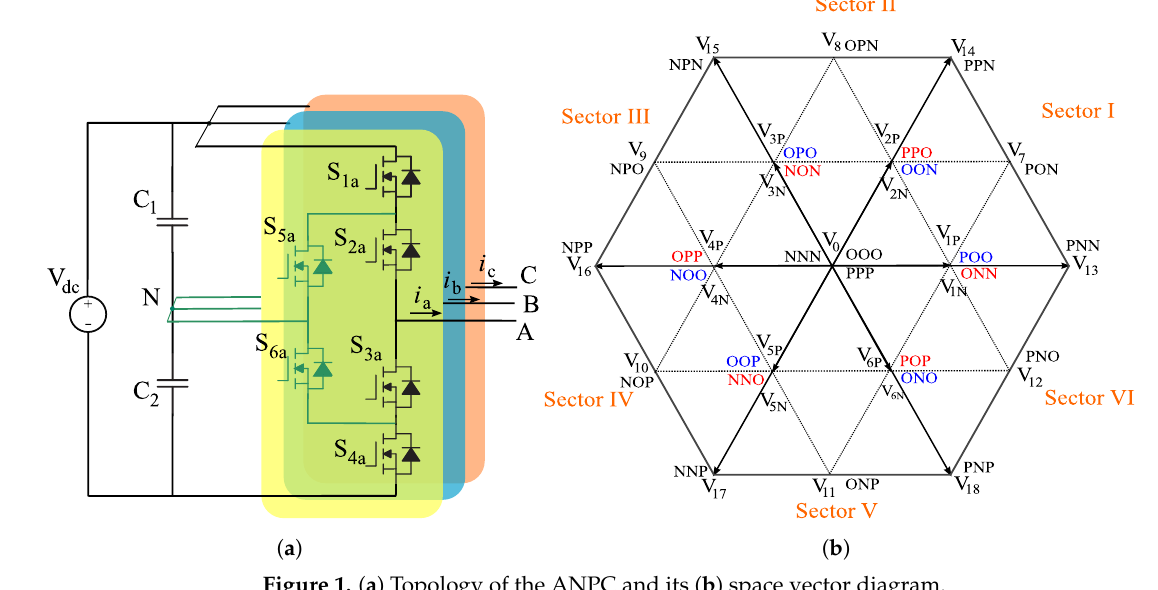
Figure 1. ( a ) Topology of the ANPC and its ( b ) space vector diagram. Table 1. Switching states of a three-level